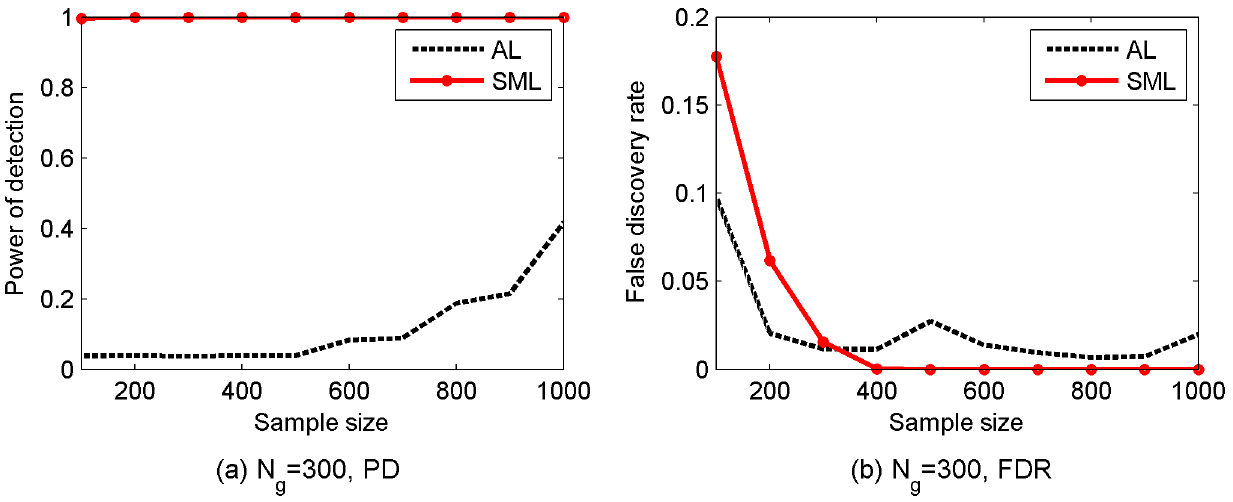
Figure 4. Performance of the SML and AL algorithms for directed acyclic networks of N g ~ 300 genes [(a) power of detection, and (b) false discover rate]. Expected number of nodes per node is N e ~ 1 . PD and FDR were obtained from 10 replicates of the network with different sample sizes ( N ~ 100 to 1,000).